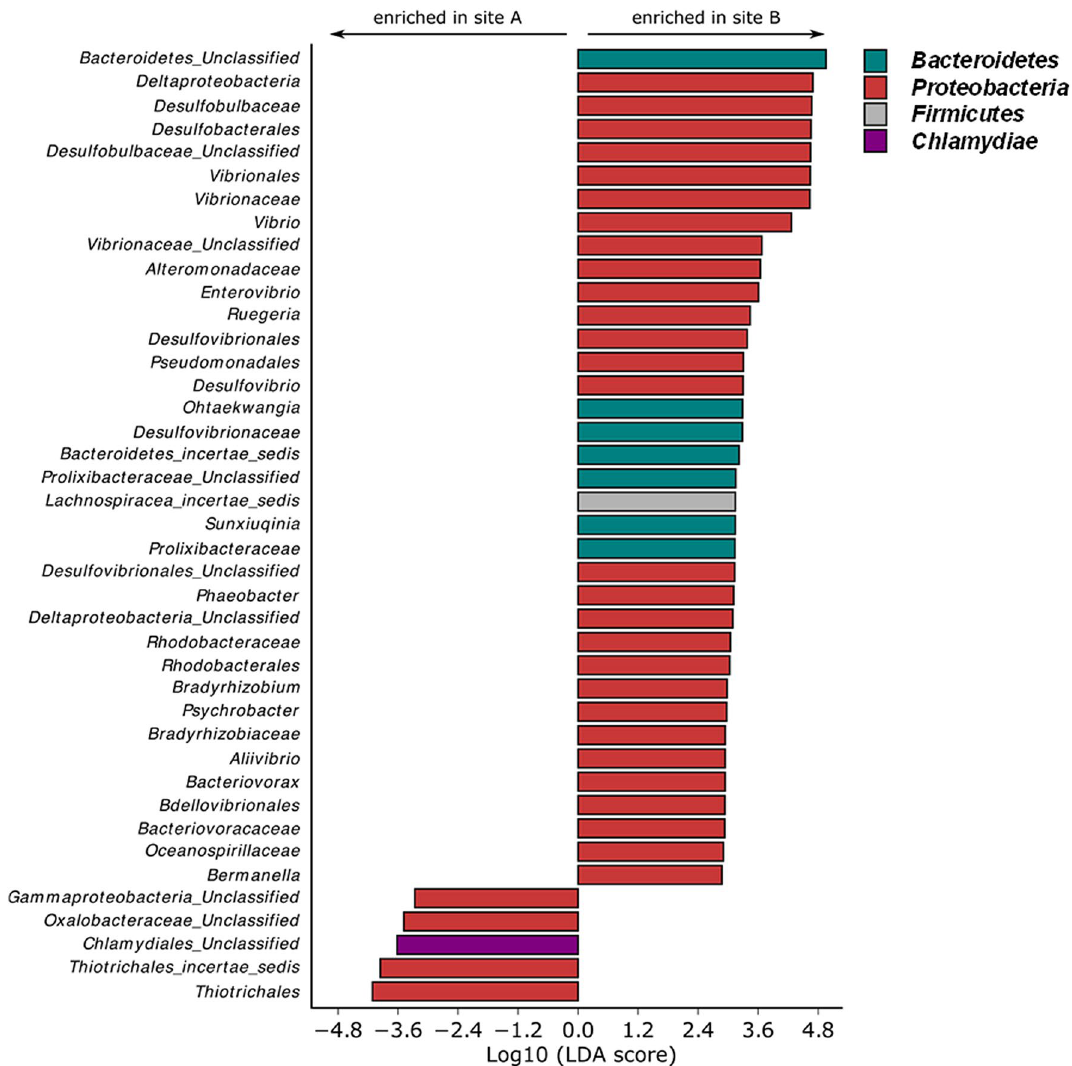
Figure 2. Comparative analysis of the most discriminant bacterial taxa in the coelomic microbiota of P. lividus individuals from site A vs site B. Log 10 of LDA scores was calculated for the most discriminant bacterial taxa identified by LEfSe. Positive and negative LDA scores indicate the taxa enriched in the coelomic microbiota of P. lividus specimens from A and site B sites, respectively. Only taxa having a p < 0.05 (Wilcoxon rank-sum test) and LDA >|2.0| are